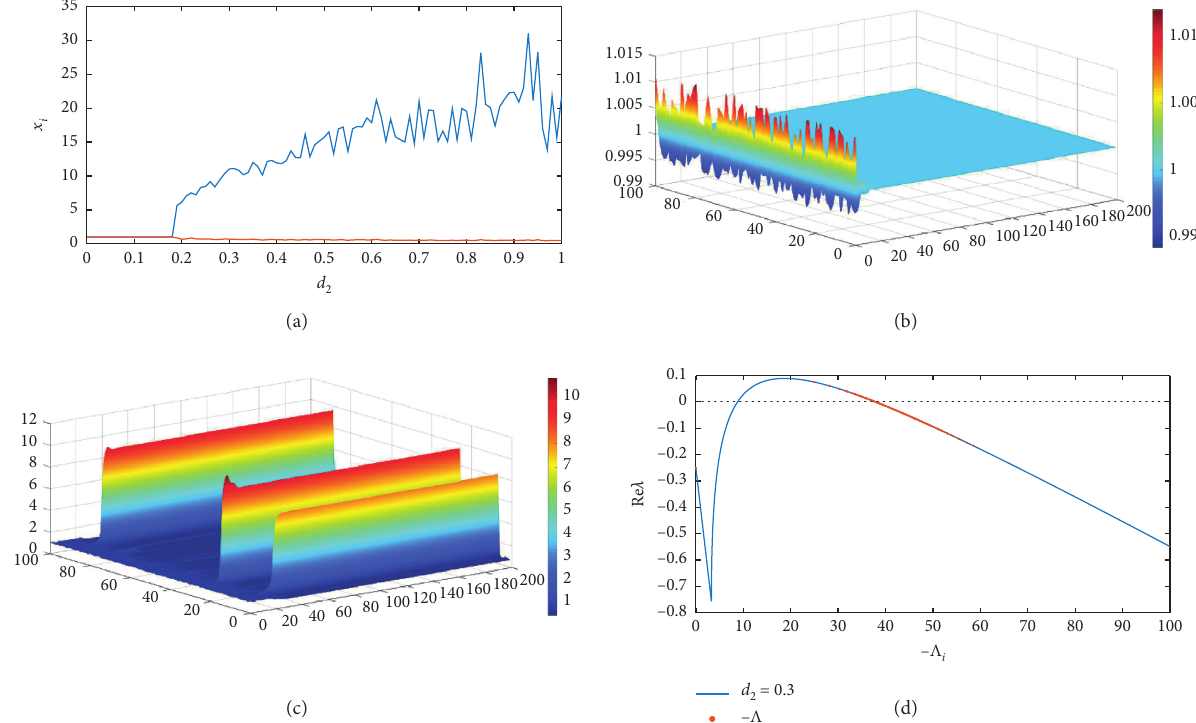
Figure 11: (a) The bifurcation diagram of d when p � 0 . 43,. The pattern formation of the system when p � 0 . 43. The system is stable when 2 d � 0 . 1 (b) and when d � 0 . 3 (c). (d) When some − Λ i fall into the instability region, Turing instability occurs in the system. 2 2